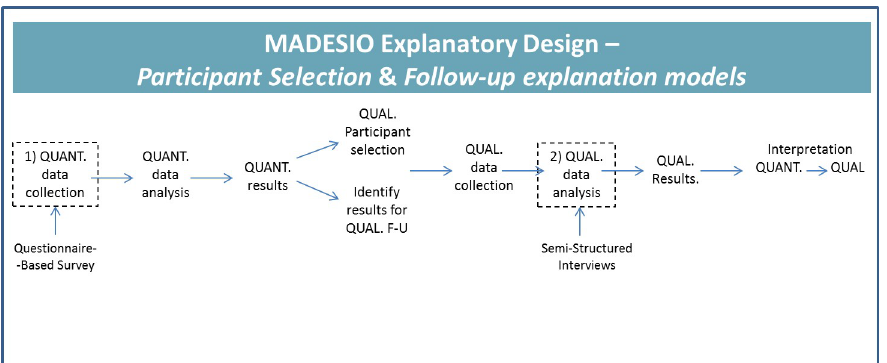
Fig 1. MADESIO explanatory